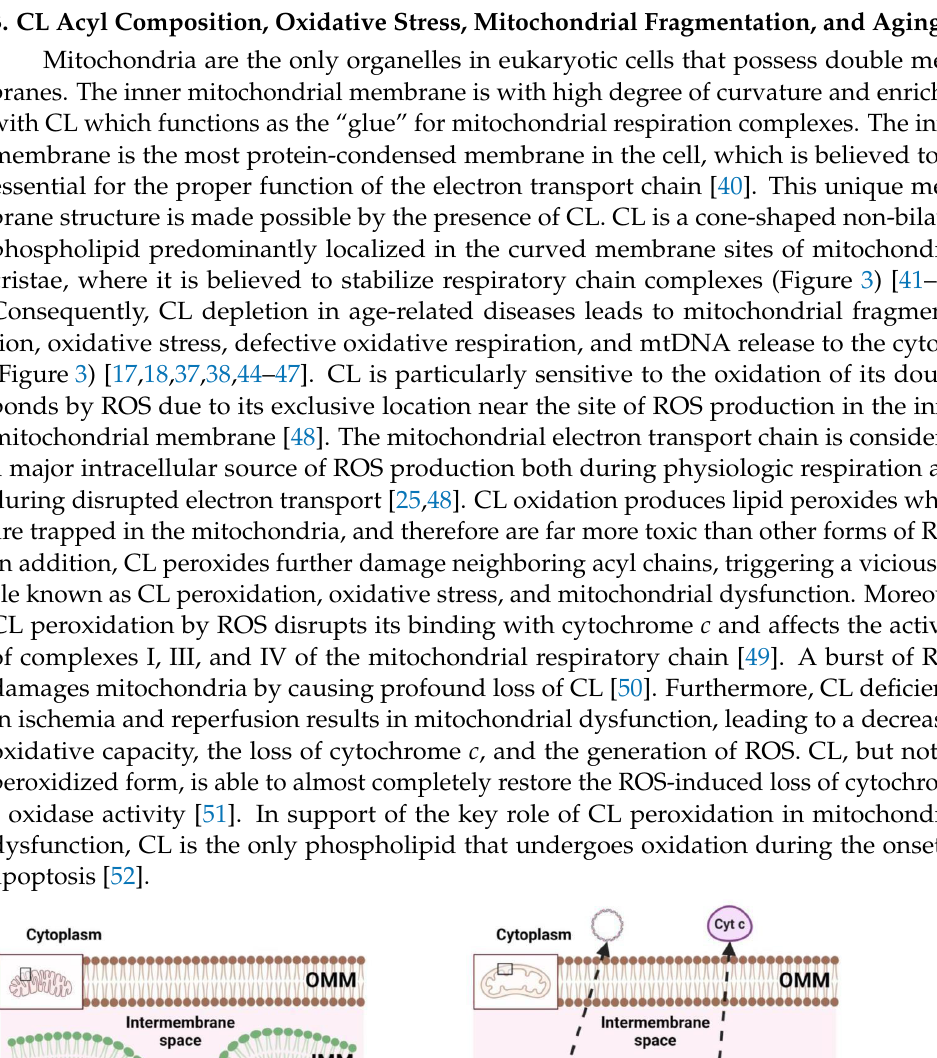
tochondrial phosphate transporter, pyruvate carrier, adenine nucleotide transporter, and